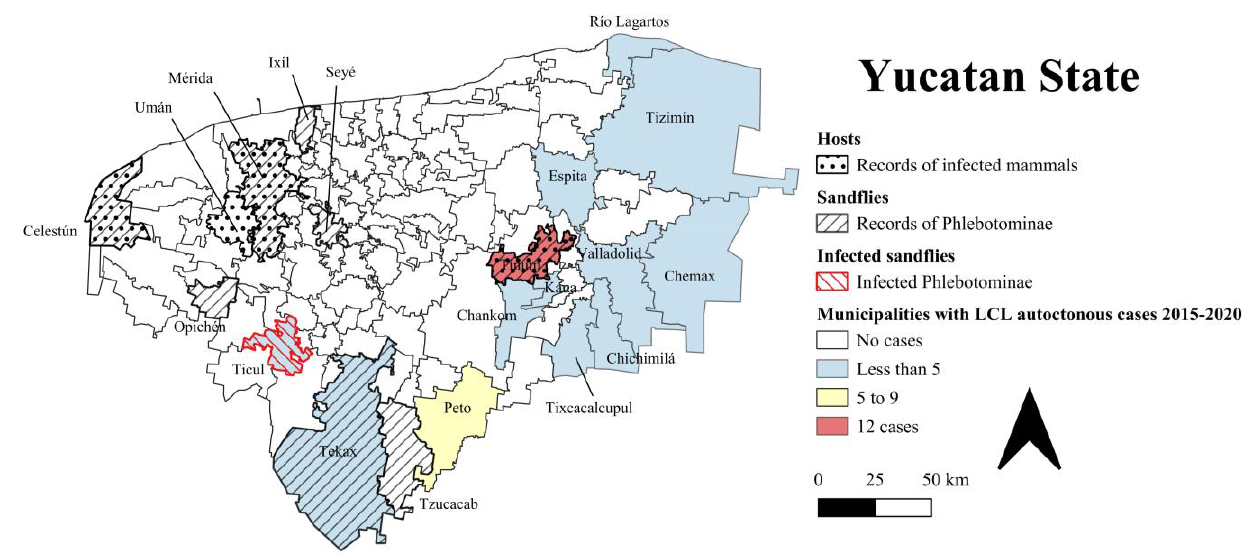
Figure 1. Geographical distribution of mammal hosts infected by Leishmania , vector sandfly species, and autochthonous LCL human cases in Yucatan state. Dotted boxes: municipalities with record of Leishmania infected mammals [18–21]. Boxes with lines: municipalities with vector sandfly species reports [22–25]. Color boxes: municipalities with diagnosed autochthonous cases of LCL from 2015 to 2020.